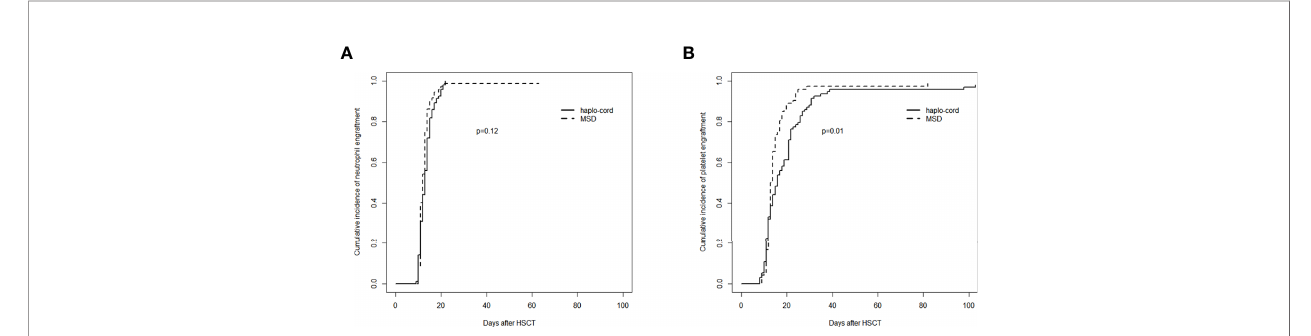
FIGURE 1 | Assessment of hematopoietic recovery after transplantation in haplo-cord group and MSD group: (A) cumulative incidence of neutrophil engraftment and (B) cumulative incidence of platelet engraftment. MSD, matched sibling